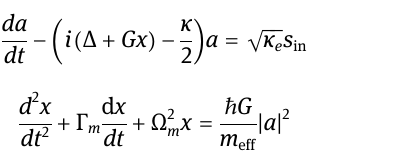
Figure 6: (a) Simulated self-induced oscillations showing the evo- lutionof the intracavityphotons versustimein logarithmicscale. (b) Close view of the saturated oscillation with a stable amplitude cor-